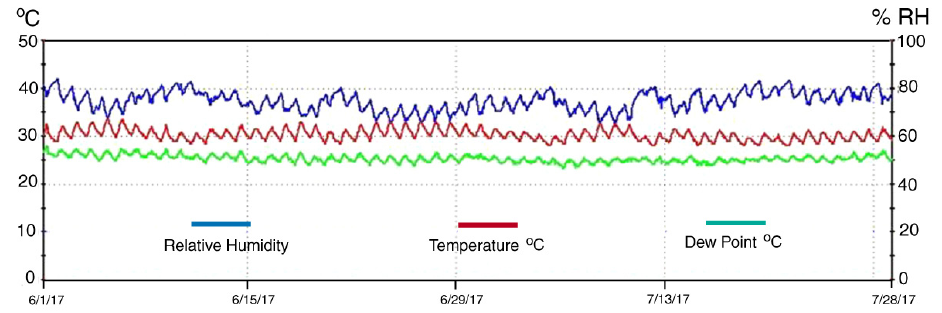
Figure 19. Microclimate variations in fossil log BT-1, recorded during early rainy season, 2017. The log was in a temporary shelter. Measurements were made at a length of 68 m from the base of the trunk [10].